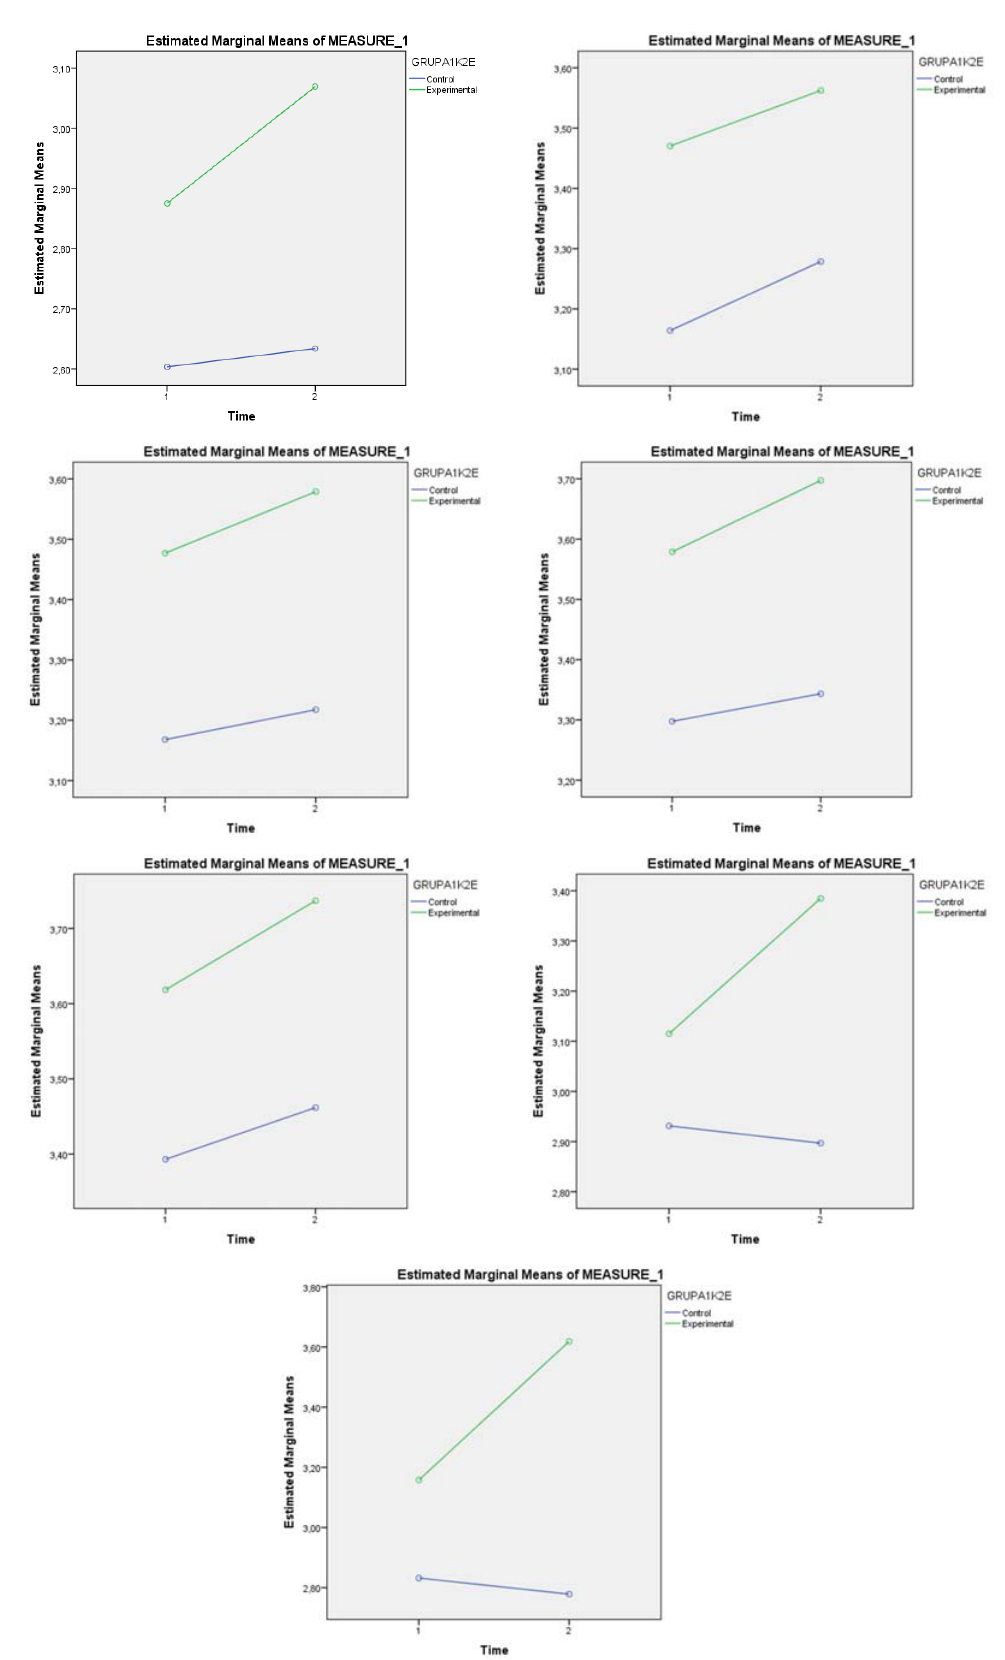
Figure 1. Scale values of the experimental and the control groups at pre ‐ test and post ‐ test.